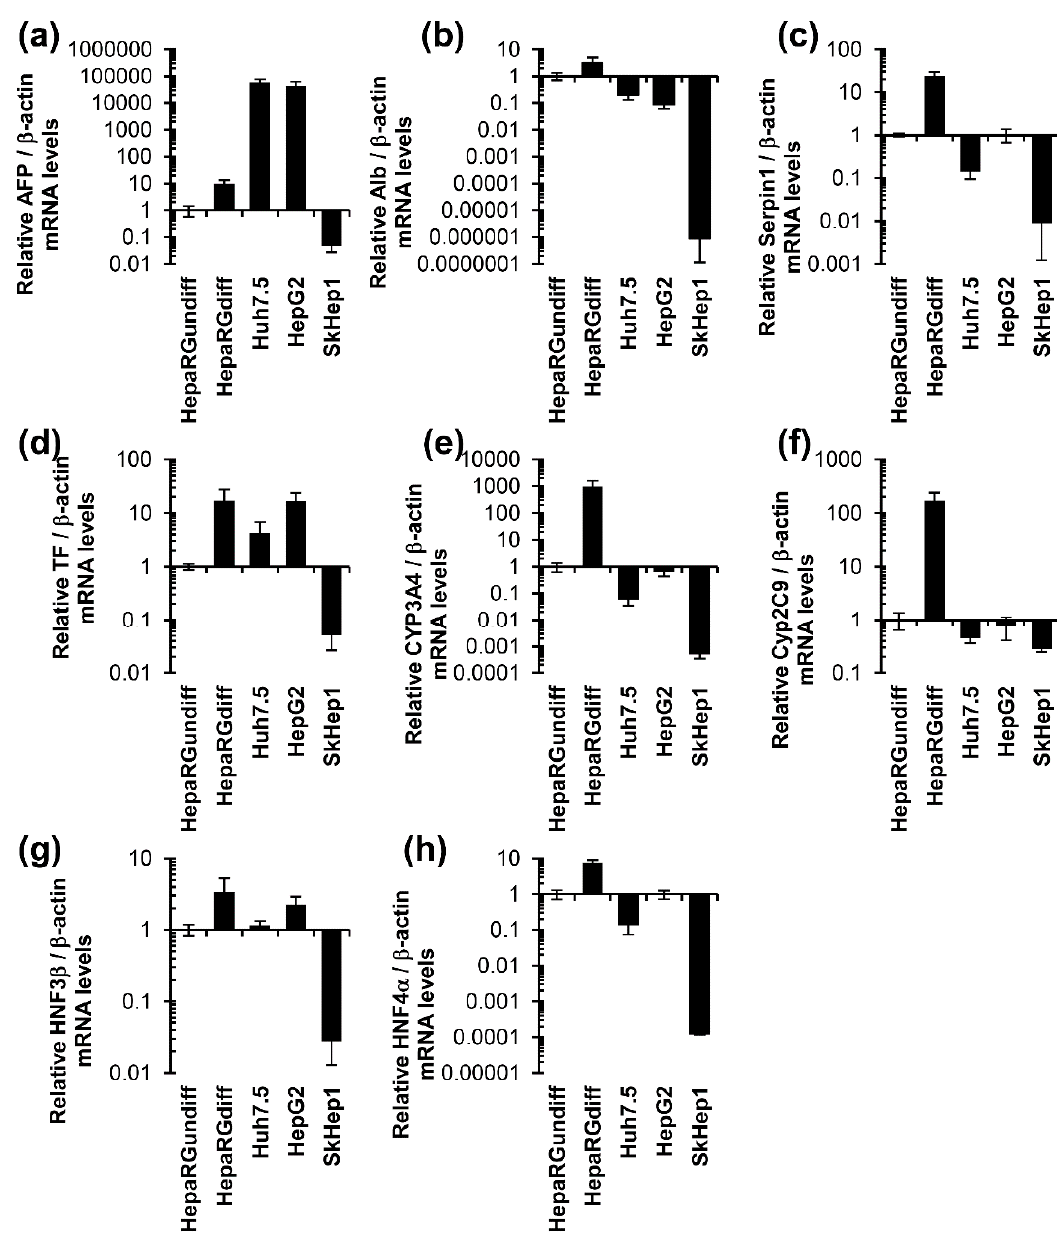
Figure 1. HepaRG cells compared to Huh7.5, HepG2 and SkHep1 cells exhibit highest expression of hepatocyte-specific genes. Expression of genes in noncancer undifferentiated (HepaRG undiff ) and differentiated (HepaRG diff ) HepaRG, hepatocarcinoma Huh7.5 and HepG2 and adenocarcinoma SkHep1 cells was assessed by RT-qPCR, and the results were normalized to the level of β -actin mRNA. These resulting ratios were normalized to the values obtained for undifferentiated HepaRG cells. The genes include α -fetoprotein (AFP) ( a ), albumin (Alb) ( b ), α -antitrypsin (Serpin 1) ( c ), transferrin (TF) ( d ) cytochromes P450 3A4 (CYP3A4) ( e ) and 2C9 ( f ), hepatocyte nuclear factors 3 β (HNF3 β ) ( g ) and 4 α (HNF4 α ) ( h ). Statistical analysis is presented in the Supplementary Table S3).